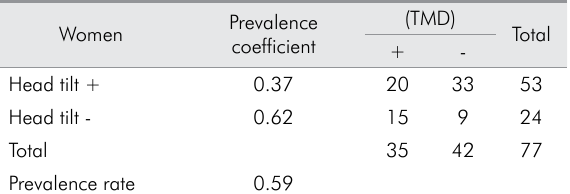
Table 1. Percentages of TMD diagnoses among women and men according to RDC/TMD.